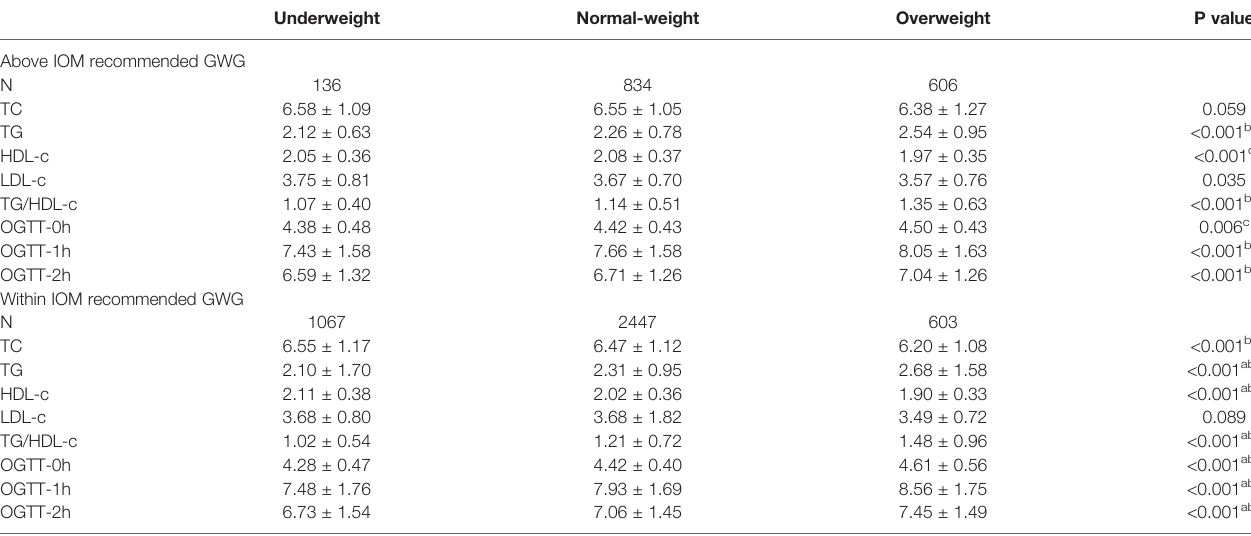
TABLE 3 | Maternal biochemical markers during second trimester strati fi ed by pre-pregnancy BMI. Underweight Normal-weight